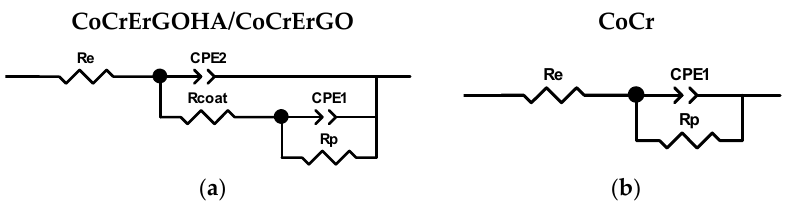
Figure 3. Equivalent circuits used for the fitting of the impedance response of CoCrErGOHA, CoCrErGO, and CoCr surfaces during testing times considering two constant times ( a ) and one constant time ( b ).